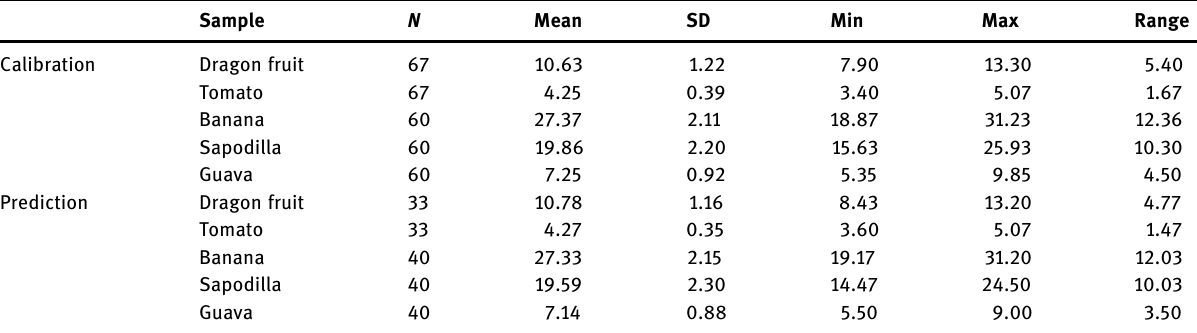
Table 3: Calibration and prediction datasets used for predicting SSC ( in °Brix ) using PLSR